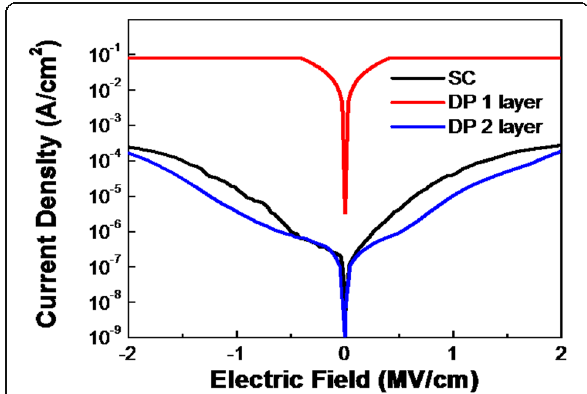
Fig. 3 Leakage current density of SC, DP1-layer, and DP2-layer ZrO